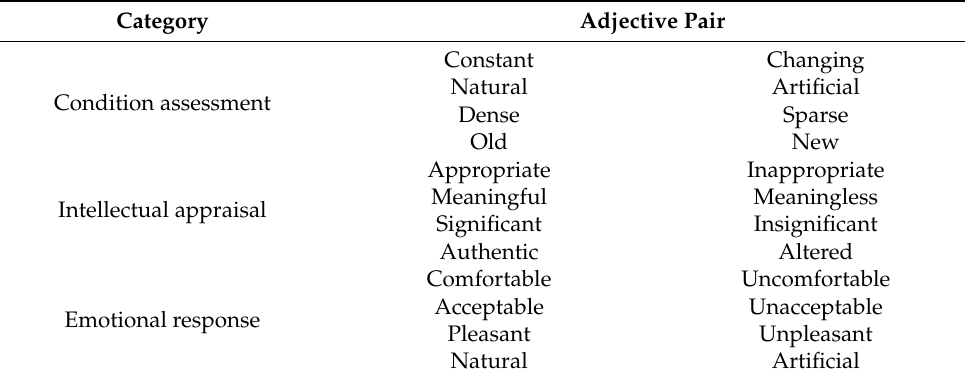
Table 1. Adjective pairs and categories targeted by